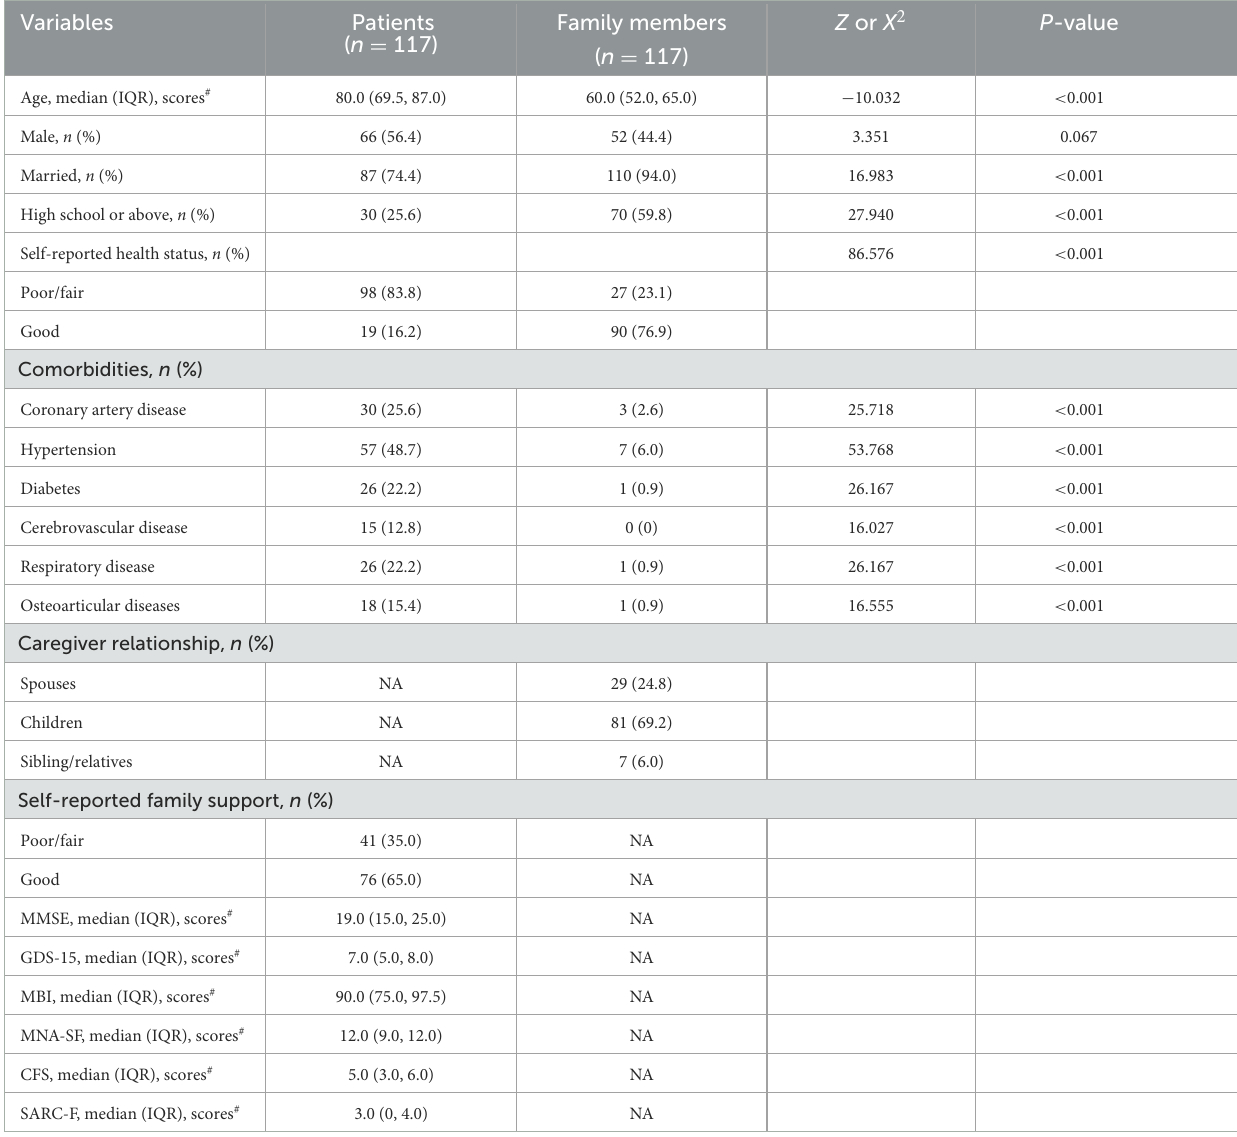
TABLE 1 Characteristics of older patients and their family members.